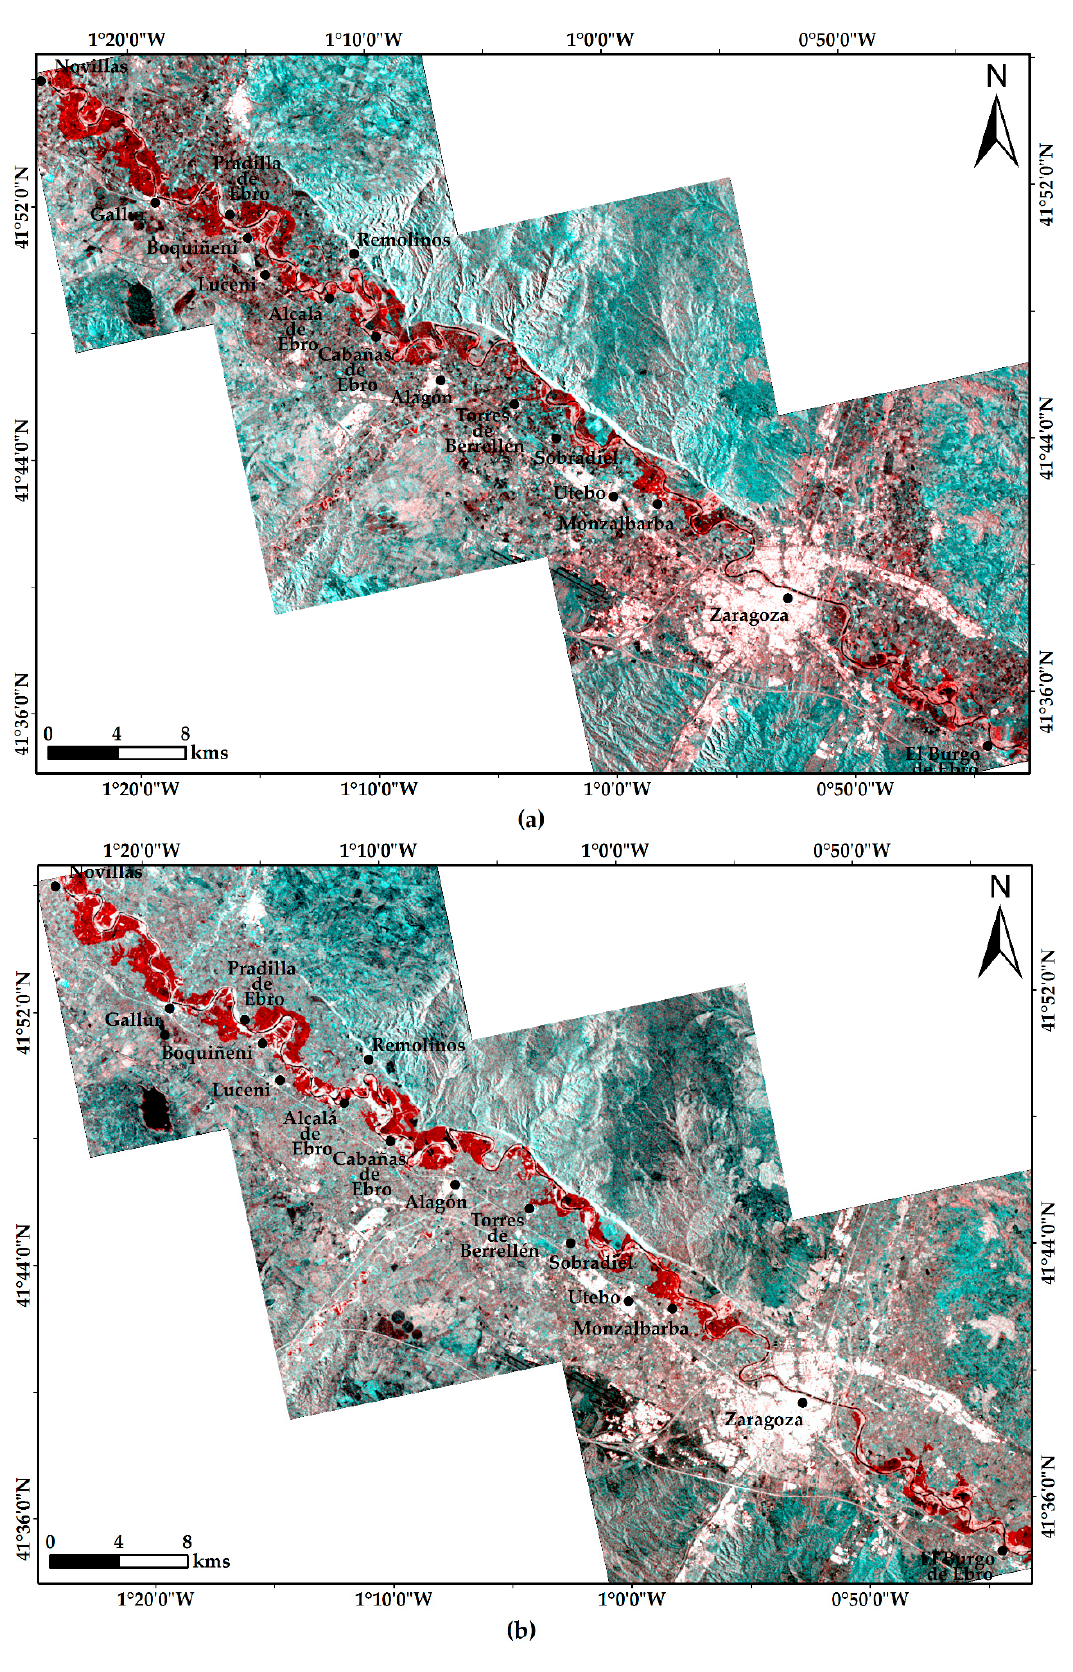
Figure 6. General flood map of the entire study area using RGB composition created from the RADAR images of 6 April 2018 and 13 April 2018: ( a ) in VV and ( b ) in VH polarization with a Lee 7 × 7 window size filter.